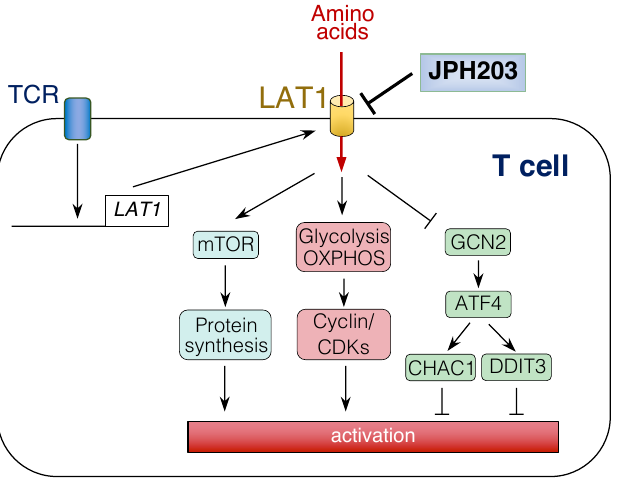
Figure 2. Regulation of T cell activation by L-type amino acid transporter (LAT) 1. In activated T cells, LAT1 is upregulated to facilitate amino acid uptake. JPH203, a LAT1-specific inhibitor, atten- uates mechanistic target of rapamycin (mTOR) and metabolic reaction, and contrary, activates acti- vating transcription factor (ATF) 4, leading to inhibition of T cell activation. CHAC1: ChaC gluta- thione specific gamma-glutamylcyclotransferase 1, CDK: cyclin-dependent kinase, DDIT3: DNA damage-inducible transcript 3, GCN2: general control nonderepressible 2, OXPHOS: oxidative phosphorylation, TCR: T cell receptor.